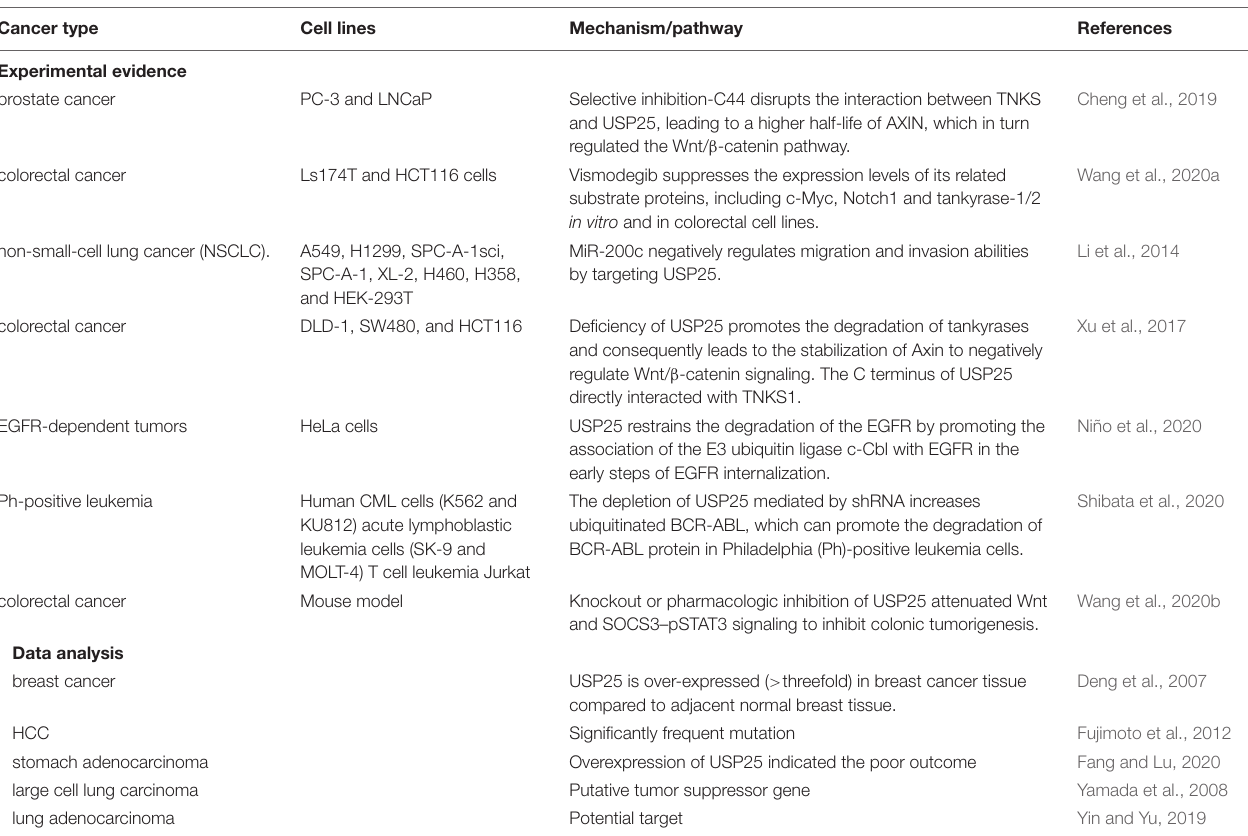
TABLE 2 | Function of USP25 in